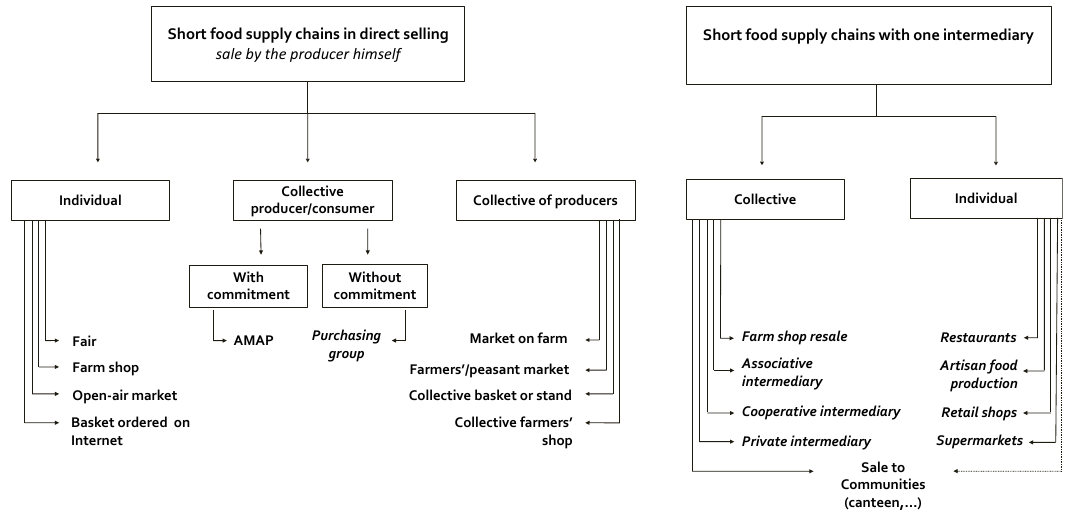
Figure 1. Diversity of short food chains in France in 2016. (Source: authors, in italics, chains not necessarily local.)